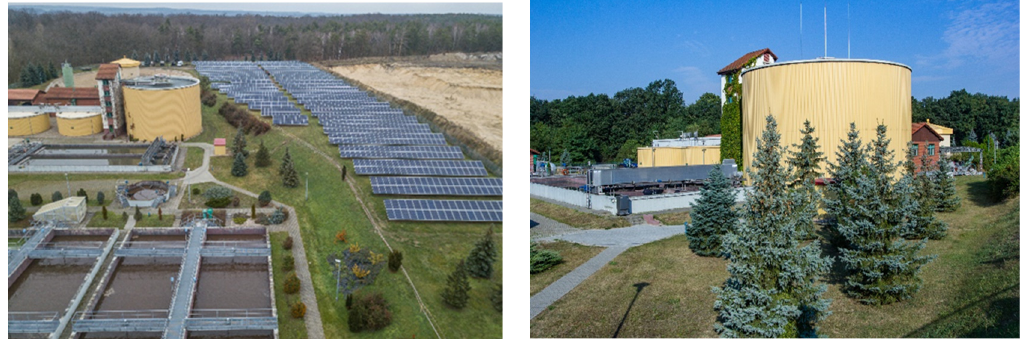
Figure 2. View of the Gubin–Guben WWTP (photo by WWTP’s Archive). The Gubin–Guben WWTP is a mechanical-biological treatment plant designed for 90,000 PE and a daily average flow of 12,000 m 3 /d (dry weather). Gubin is working with 95% of combined sewer and 5% storm sewer, and in Guben there is 90% of sanitary and storm sewer and 10% combined